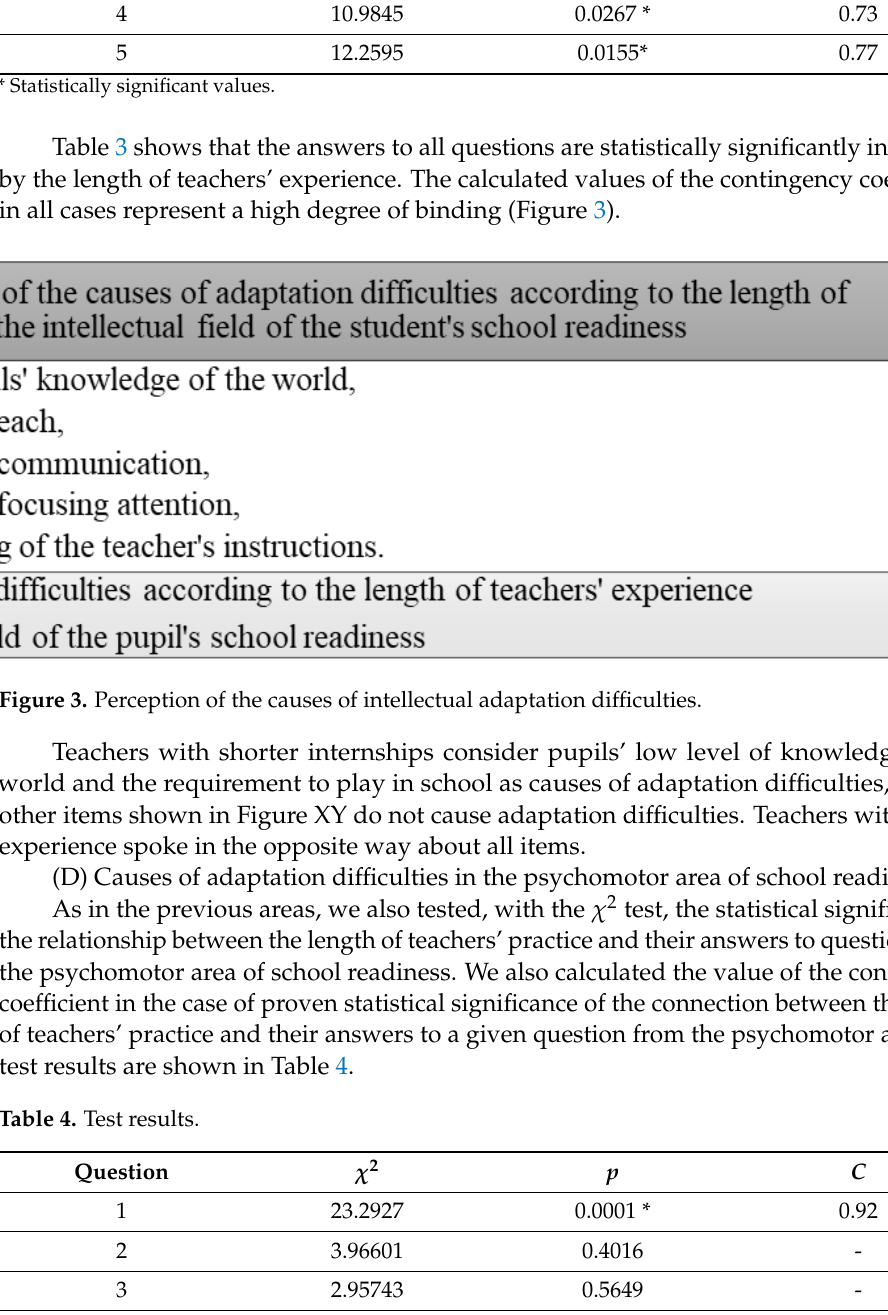
Table 4. Test results.